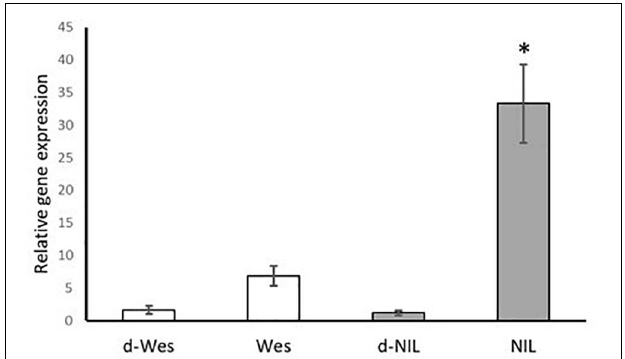
FIGURE 3 | Validation of the expression of Brassica napus CYP81F2 gene in the resistant near isogenic line (NIL) W + BLMR2 and susceptible Westar using qRT-PCR at 4 days after inoculation (dai) with Leptosphaeria maculans isolate 87-41. Samples d-Wes is water check of Westar; Wes, inoculated Westar; d-NIL, water check of NIL; NIL, inoculated NIL. The relative gene expression value is normalized using the Actin gene ( BnaA01g19850D ). Error bar shows standard deviation of the mean based on three biological replicates. The asterisk ( ∗ ) represents significant difference from all the other samples based on Tukey test, p <